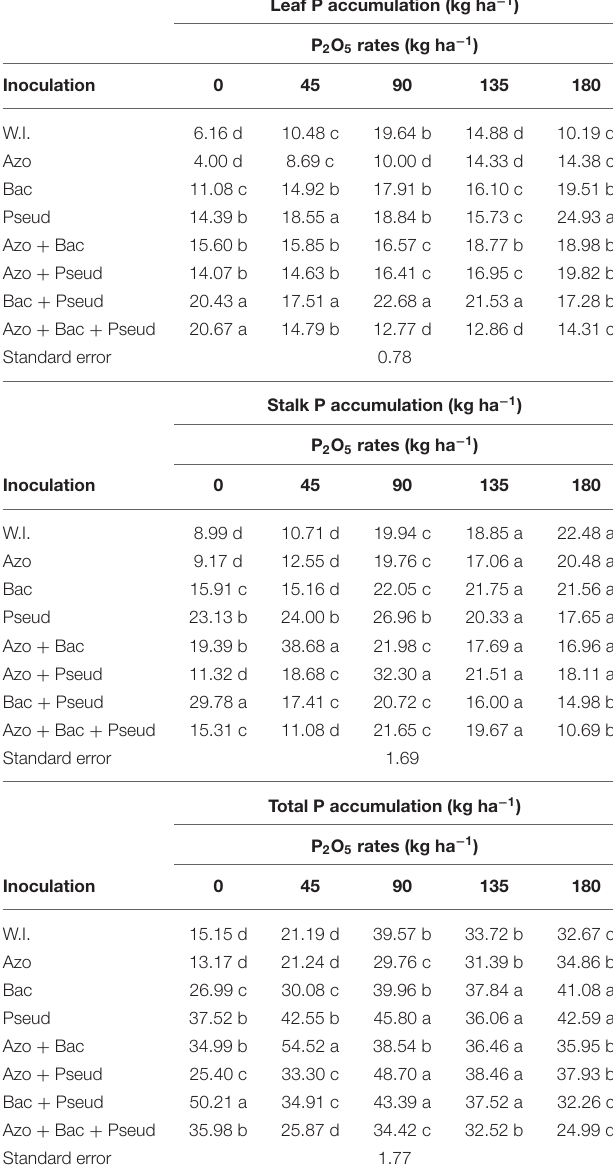
Leaf P accumulation (kg ha − 1 )